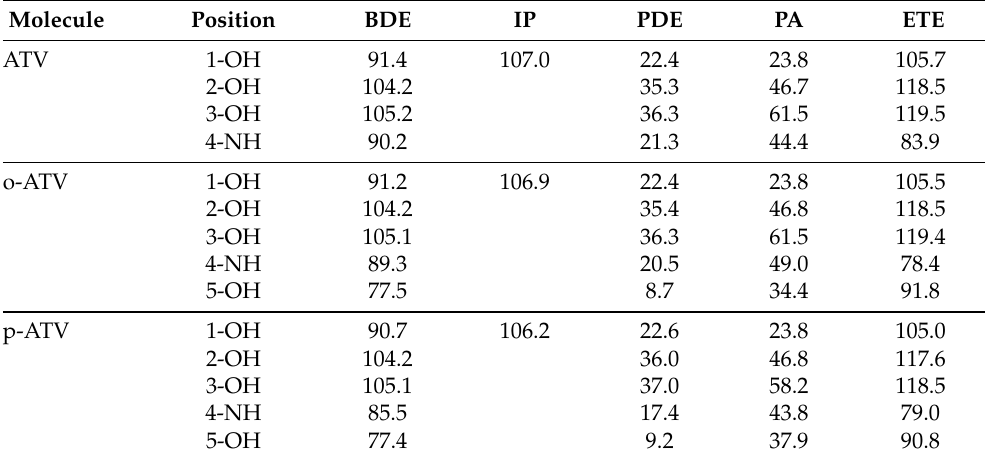
Table 4. The enthalpies of reaction (in kcal/mol) needed to quantify the antioxidant activity of atorvastatin (ATV) and its ortho- and para-hydroxy metabolites (o-ATV, p-ATV). Molecule Position BDE